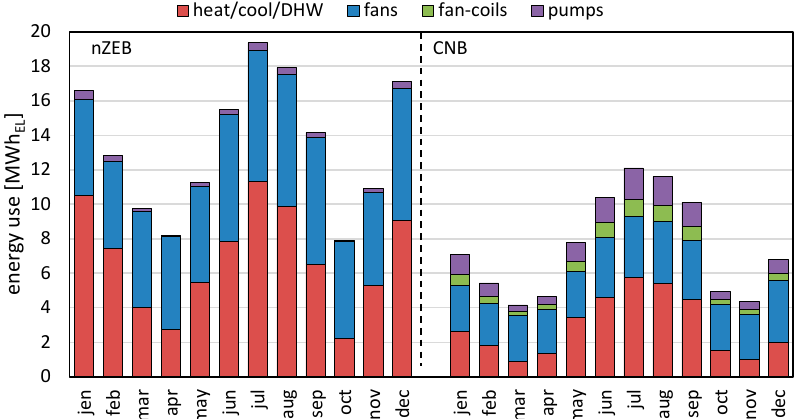
Figure 8. Overall monthly electric energy uses for heating and cooling, for nZEB ( left ) and CNB ( right )